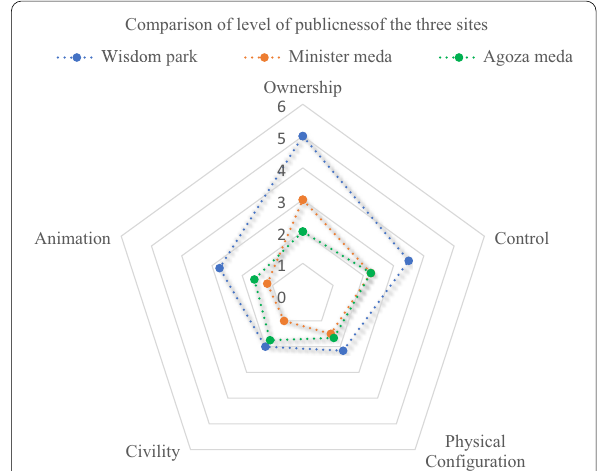
Fig. 3 Level of publicness of the three sites: Wisdom Park, Minister Meda, and Agoza